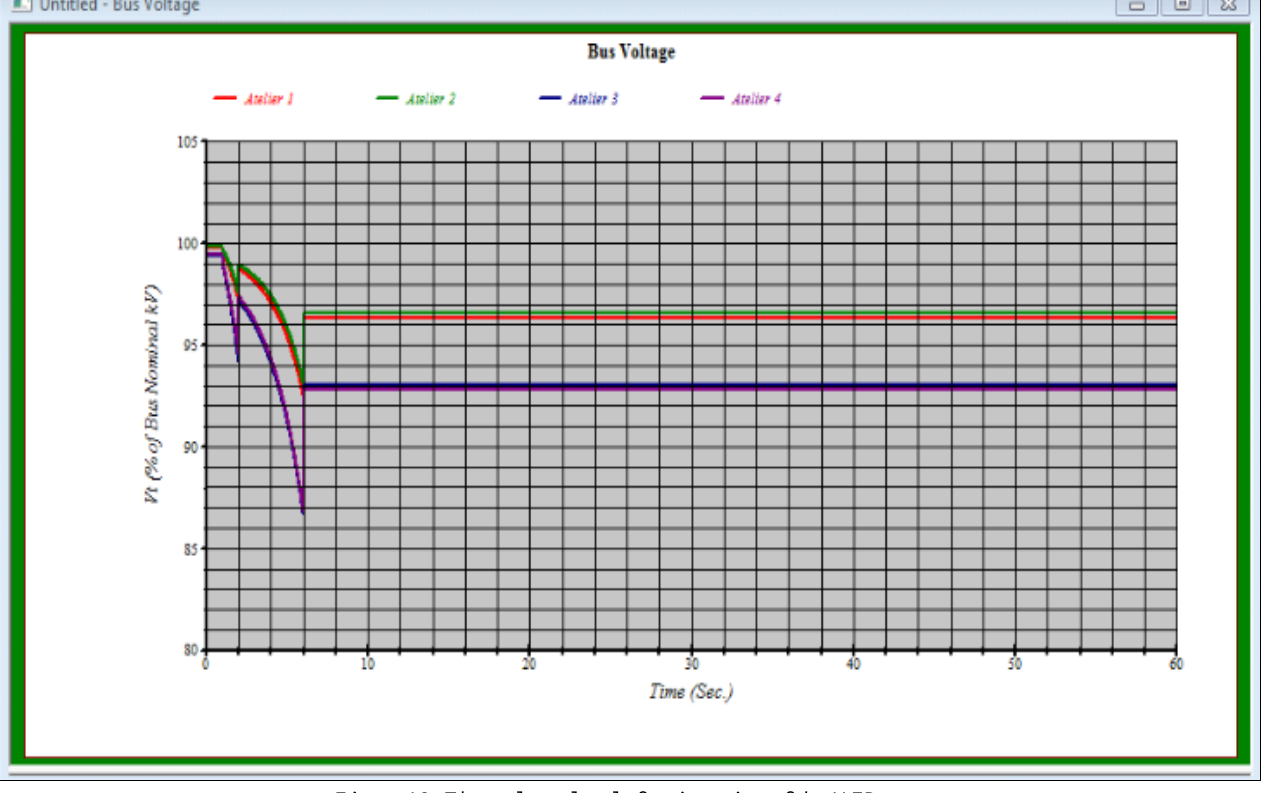
Figure 13: The voltage level after insertion of the VFDs.